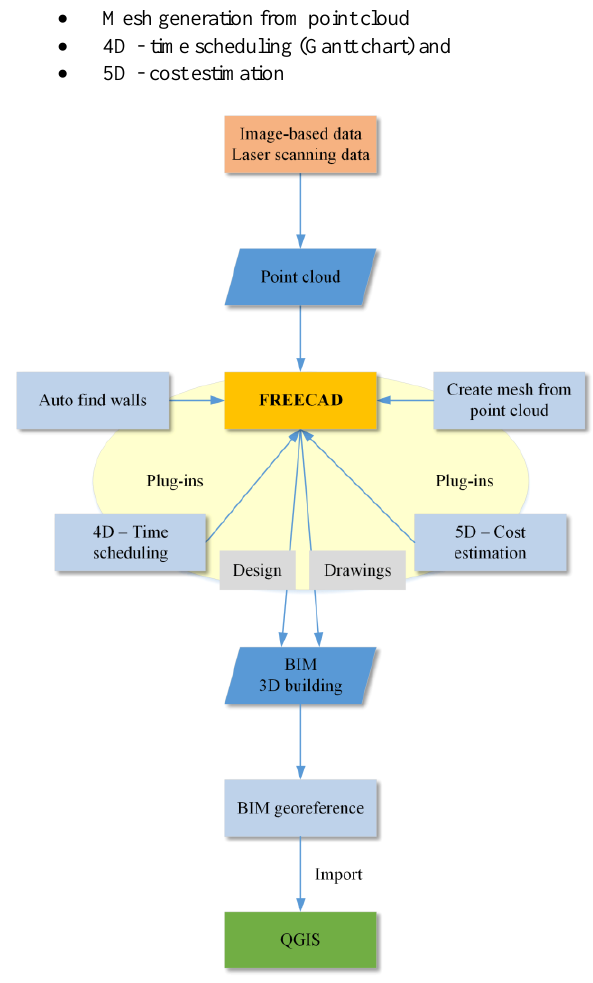
Figure 7. Workflow of plug-in under